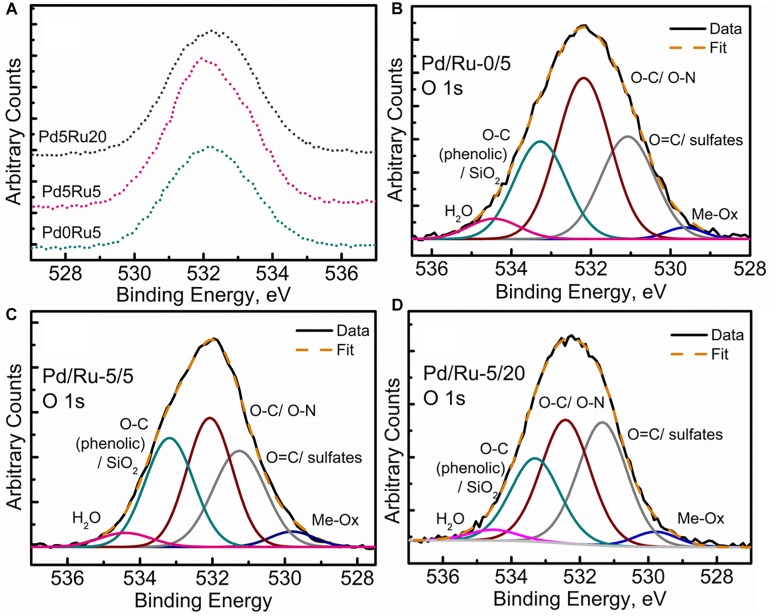
Oxygen XPS spectra showing (A) comparison of high resolution O 1s region for all three samples, (B) O 1s peak fitting for low Ru only sample, (C) O 1s peak fitting for low Pd and low Ru loading sample, (D) O 1s peak fitting for low Pd and high Ru loading sample.